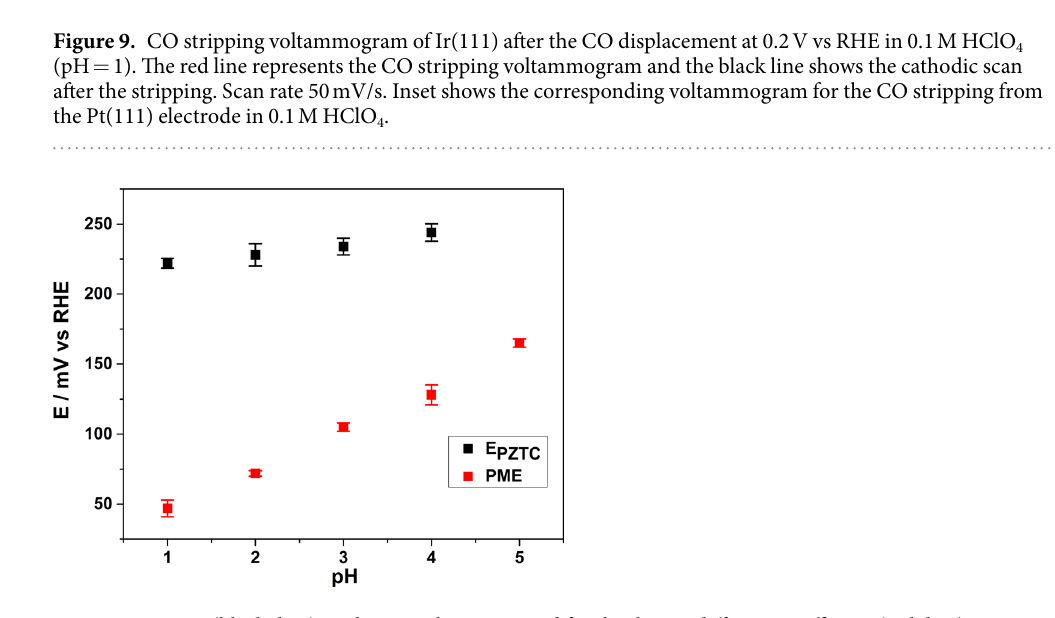
Figure 10. E PZTC (black dots), and PME values corrected for the thermodiffusion coefficient (red dots), as a function of the proton concentration in perchloric electrolytes. The composition of the electrolytes is the same as described in Fig.